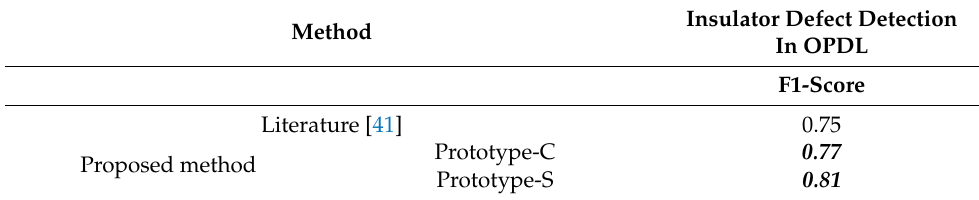
Table 6. Results of the insulator detection model on prototype dataset with proposed flight path strategy.